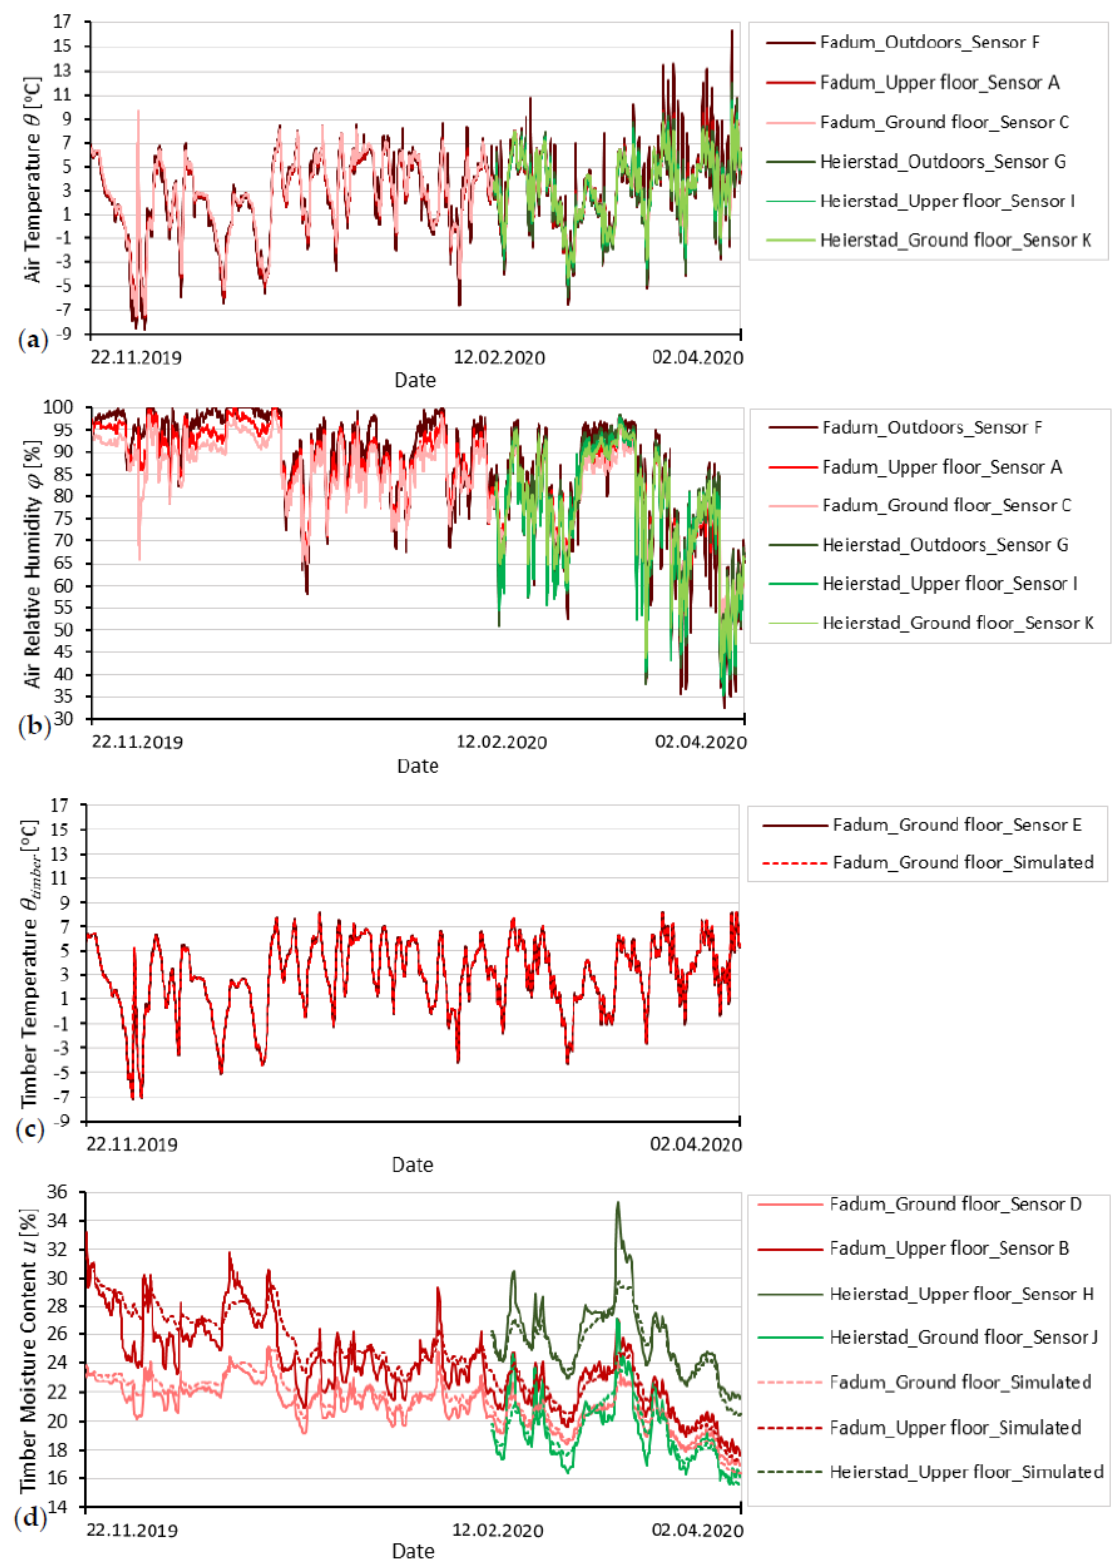
Figure 11. Measurements of the ( a ) air temperature and ( b ) relative humidity, which have been used as boundary conditions in the hygrothermal models, and both measured and simulated ( c ) temperature and ( d ) moisture content in the timber building components.